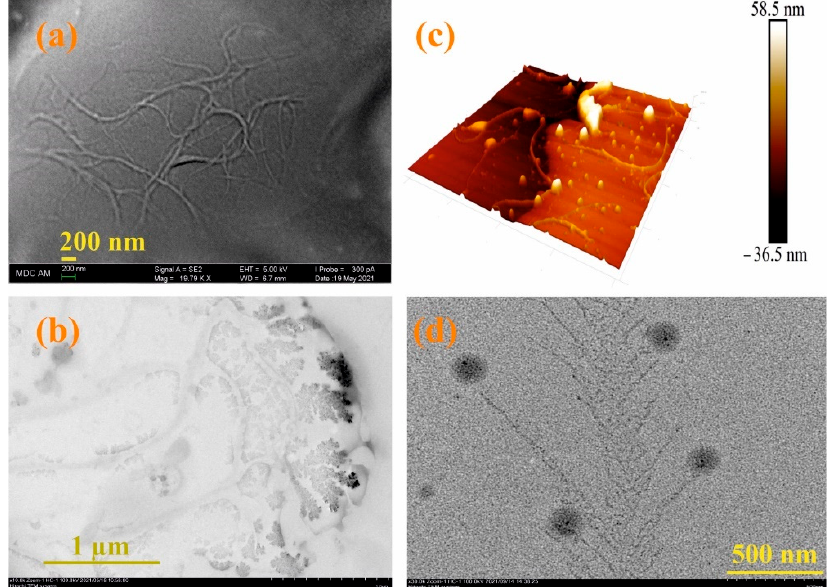
Figure 5. ( a ) SEM images of 3/4Sn (1 × 10 − 5 M) after the solvent (THF: CH 3 OH (100:1)) evaporation; ( b ) AFM images of a 3/4Sn film (1 × 10 − 5 M) after the solvent (THF: CH 3 OH (100:1)) evaporation; ( c ) TEM images of 3/4Sn film (1 × 10 − 5 M) after the solvent (THF:CH 3 OH (100:1)) evaporation; ( d ) TEM images of system 3/4S (1 × 10 − 5 M)/ moxi (1 × 10 − 4 M) after the solvent (THF:CH 3 OH (100:1)) evaporation.